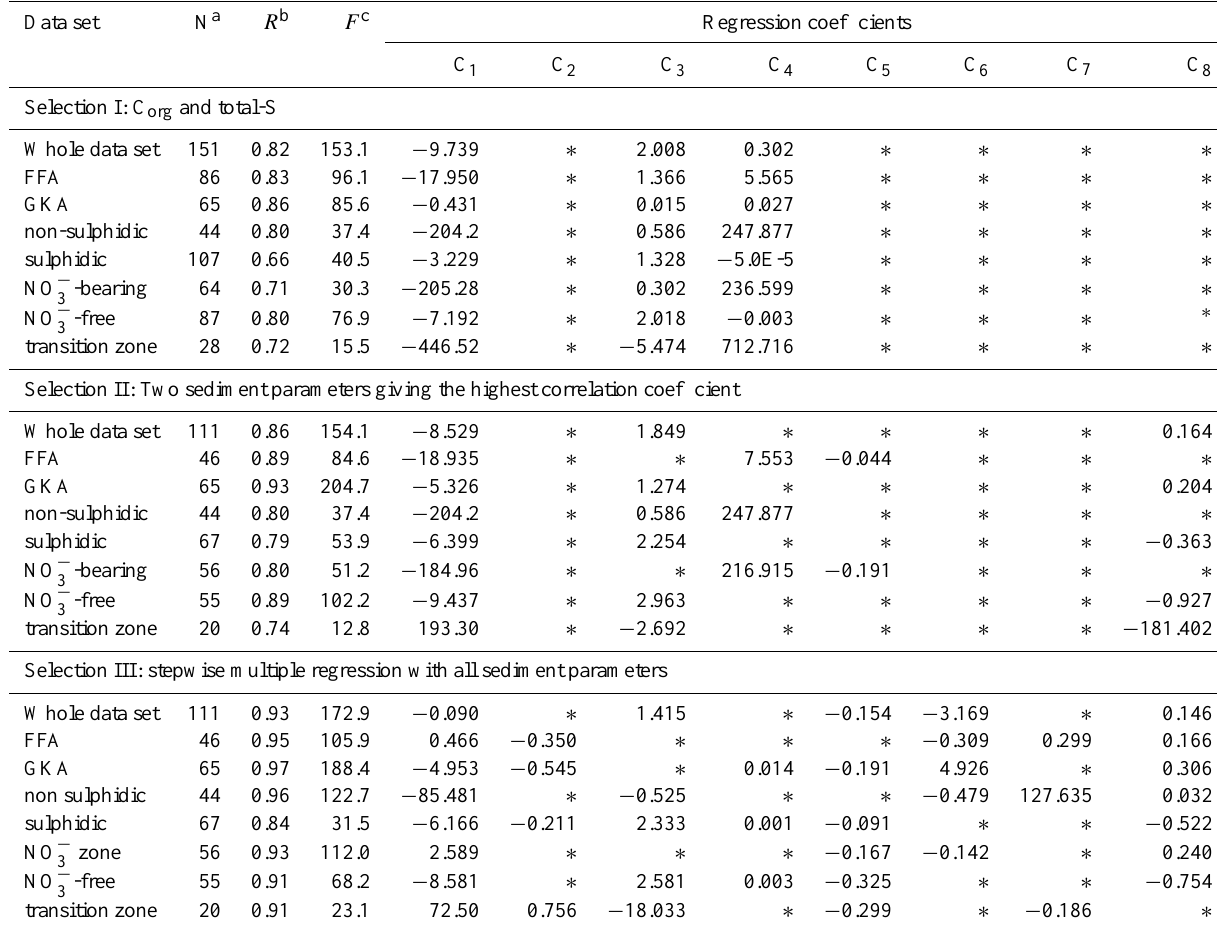
Table 5. Results of multiple linear regression analysis between D cum (365) and various selections of sediment parameters. To achieve normal distribution, all variables in the different data sets were Box–Cox transformed. Regression coefficients are given for the equation f B − C (D cum (365))=C 1 +C 2 × f B − C (%silt)+C 3 × f B − C (C org mgkg − 1 )+C 4 × f B − C (total-Smgkg − 1 )+C 5